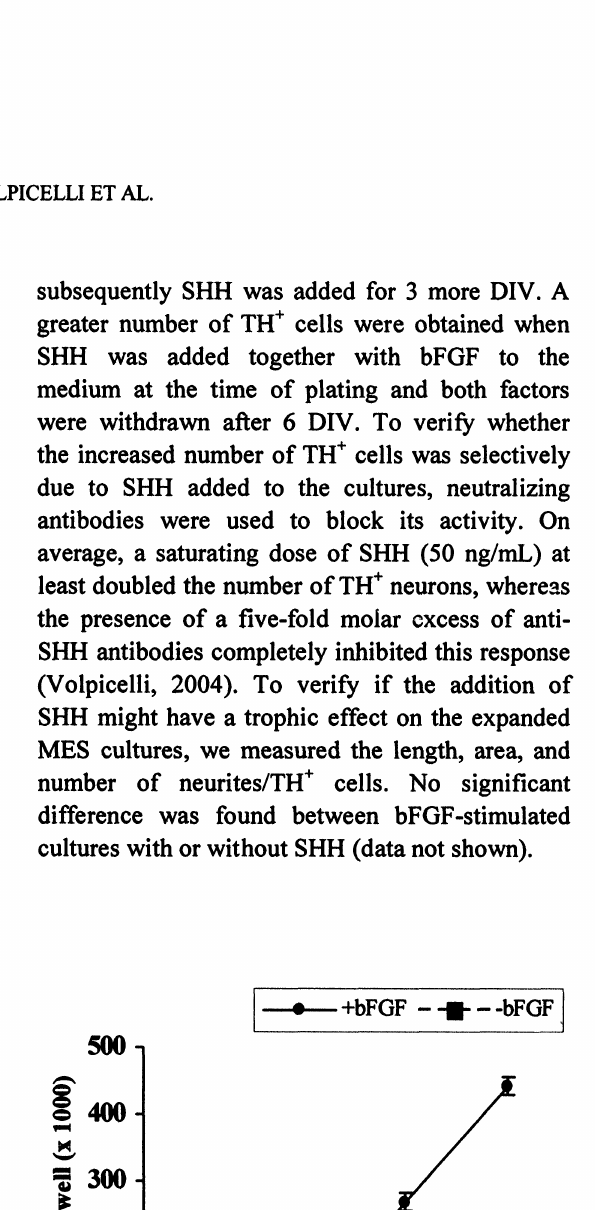
Fig. 1: Expansion ofmesencephalic precursors in vitro. Comparison of bFGF treated (+bFGF) and control cultures (-bFGF) at different days in vitro (DIV). Every value represent the mean +/- SEM of triplicate samples for each experimental